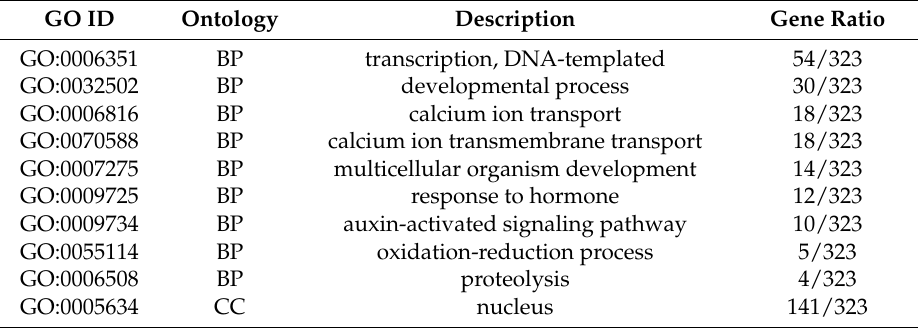
Table 2. GO category of targets of known DEMs identified by degradome. GO